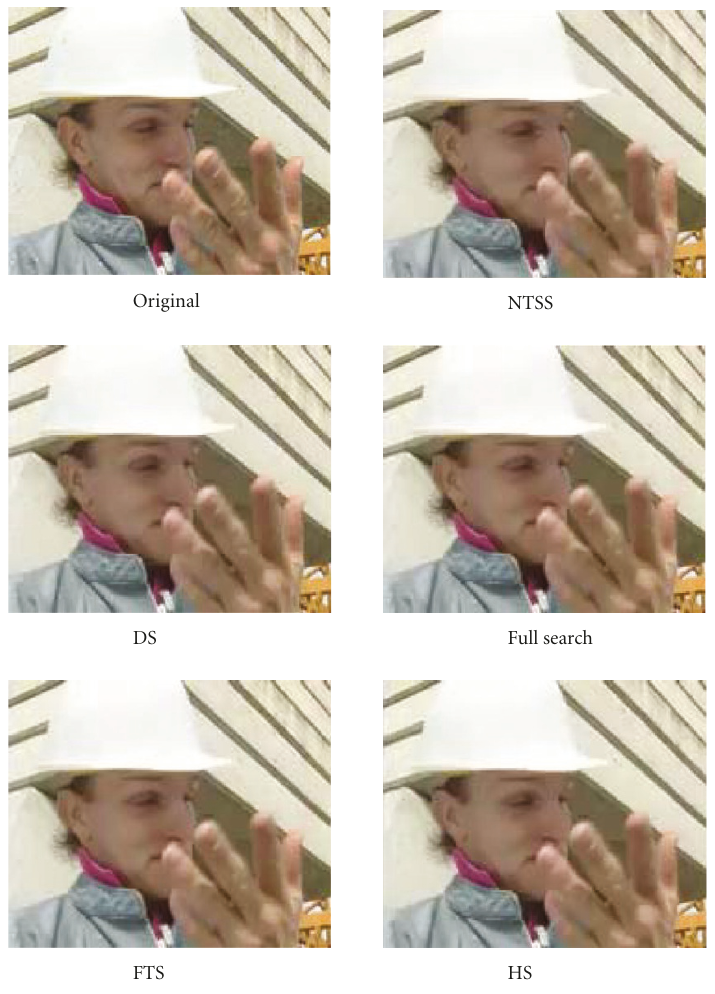
Figure A.1: Reconstructed frame number 255 for Foreman